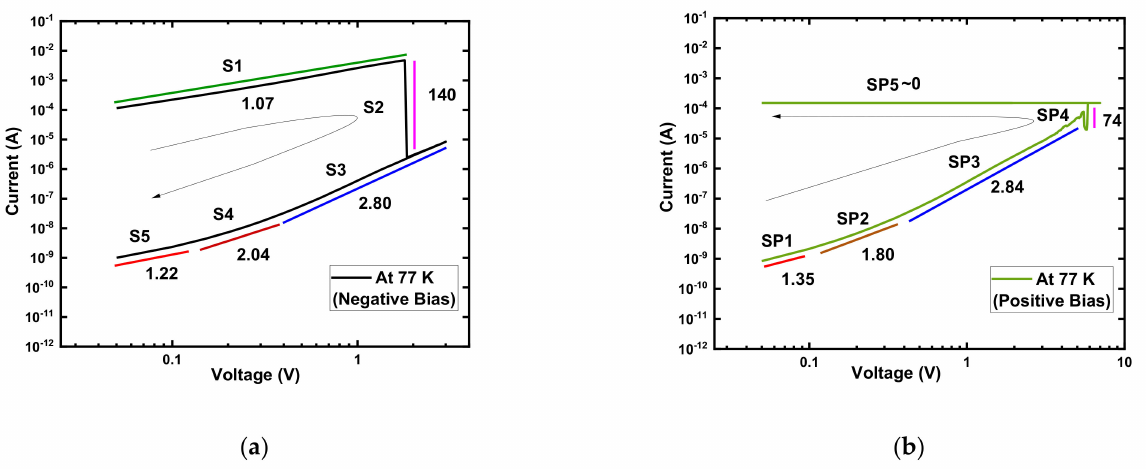
Figure 4. Log (I)–log (V) characteristics of Au/Ni/SiO x N y /p + -Si memory devices with I cc = 0.15 mA at 77 K. ( a ) Negative bias voltage region; ( b ) positive bias voltage region with slopes of different parts. In the negative voltage region, the slope of the LRS (S1: 1.07) indicated ohmic conduc- tion (I ∝ V). At the RESET voltage region (S2: 140), the conduction mechanism followed Child’s law ((I ∝ V n where n = 4–150). At higher voltages, the slopes of the HRS (S3: 2.8, S4: 2.04) followed Child’s law ((I ∝ V n where n = 1.5–3). The positive voltage region also